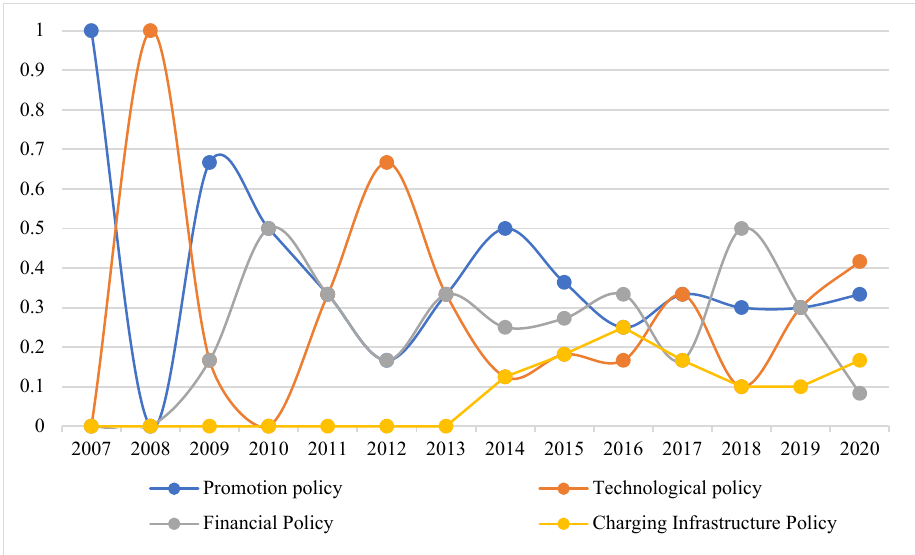
Figure 4. The policy intensity of different policies in 2007–2020. The growth and changes in policy intensity at different periods have different per- formances. The policy intensity increases of various policies in the early period changed obviously, and the growth rate was stable later, as shown in Figure 5. The increase in the policy intensity of financial policies gradually weakened from 2016 to 2020. This is a good sign of the healthy development of the industrial policy system. The financial policies stimulate industrial development, while also increasing the financial burden. The policy intensity of the promotion policy was maintained at a stable level from 2016 to 2020. The policy intensity of the charging infrastructure policy tended to increase from 2019 to 2020. The policy intensity of the technology policy had two small growth peaks, and it tended to be stable from 2018 to 2020. Various policies showed trends from strong to weak, which is in line with reality.